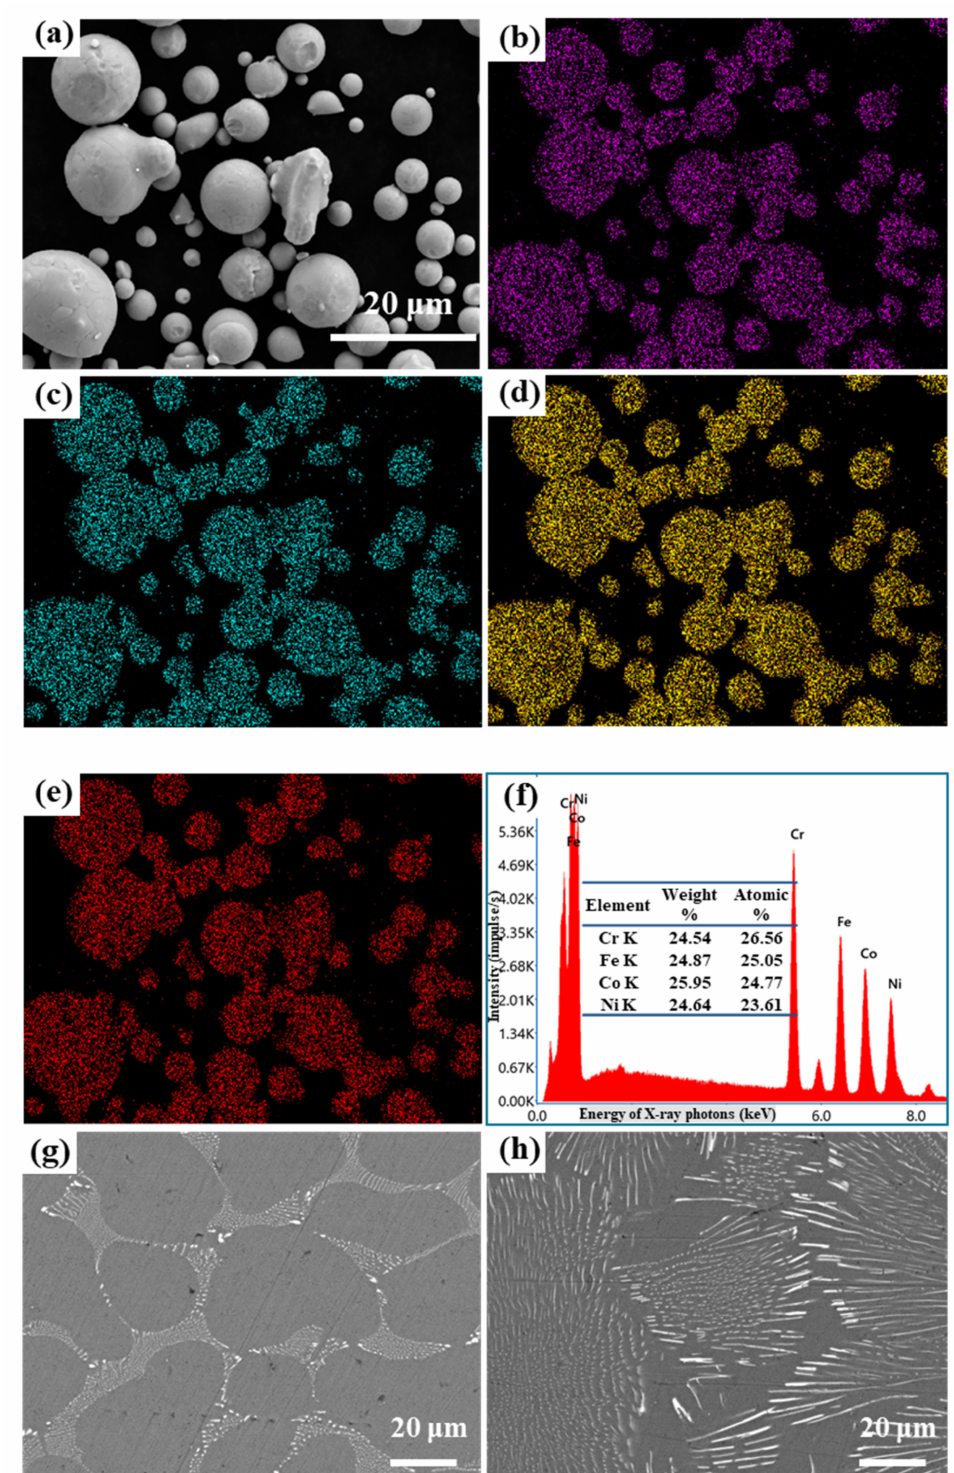
Figure 2. ( a ) SEM image of HEAp; EDS diagram results of ( b ) Ni, ( c ) Co, ( d ) Cr, and ( e ) Fe element distribution; and ( f ) Cr, Fe, Co, and Ni quantitative results of EDS elements in HEAp. ( g , h ) SEM images of 1.5 wt% and 3 wt% HEAp/AMCs before rolling